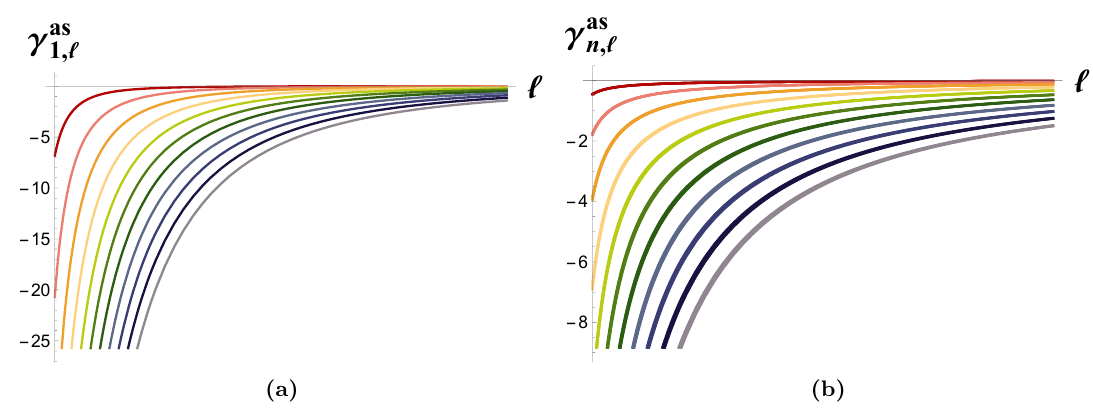
(cid:12) , at various values (cid:12) n;‘ (4 ; 0)